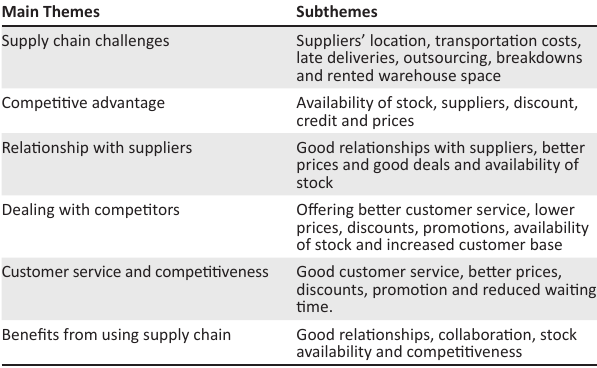
TABLE 1: Themes that emanated from the